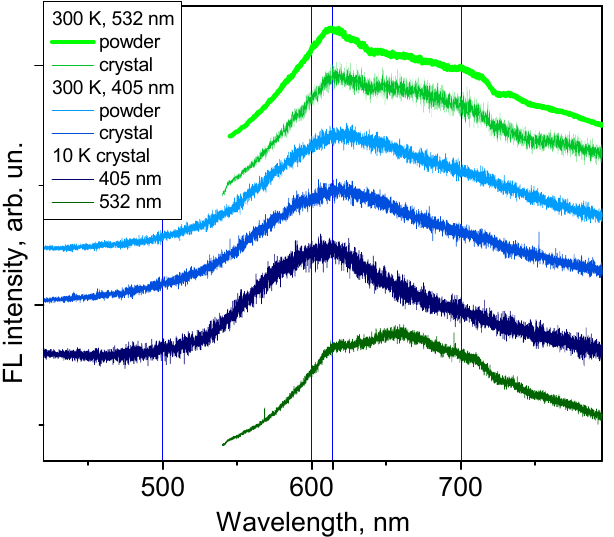
Figure 3. FL emission spectra of MH powder and M crystal at 300 K, and of M crystal at 10 K measured with two different excitation wavelengths (blue curves for 405 nm and green curves for 532 nm). To facilitate comparison the spectra are shown in arbitrary